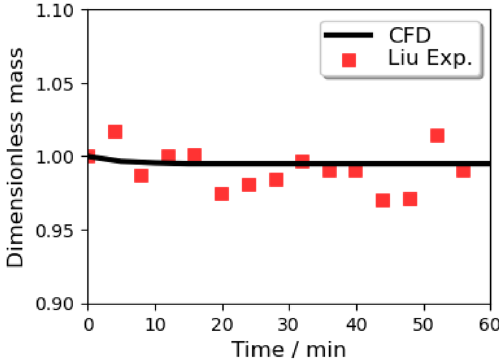
Figure 13. Dimensionless mass losses of water droplets at RH = 96% 57 .